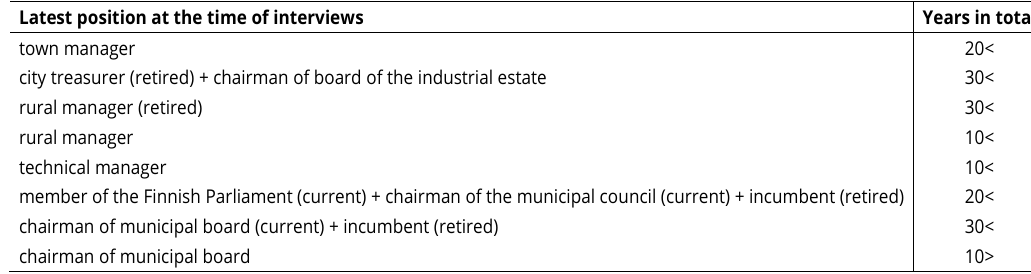
Table 1. The latest position(s) of interviewees and years in local public duties in total.